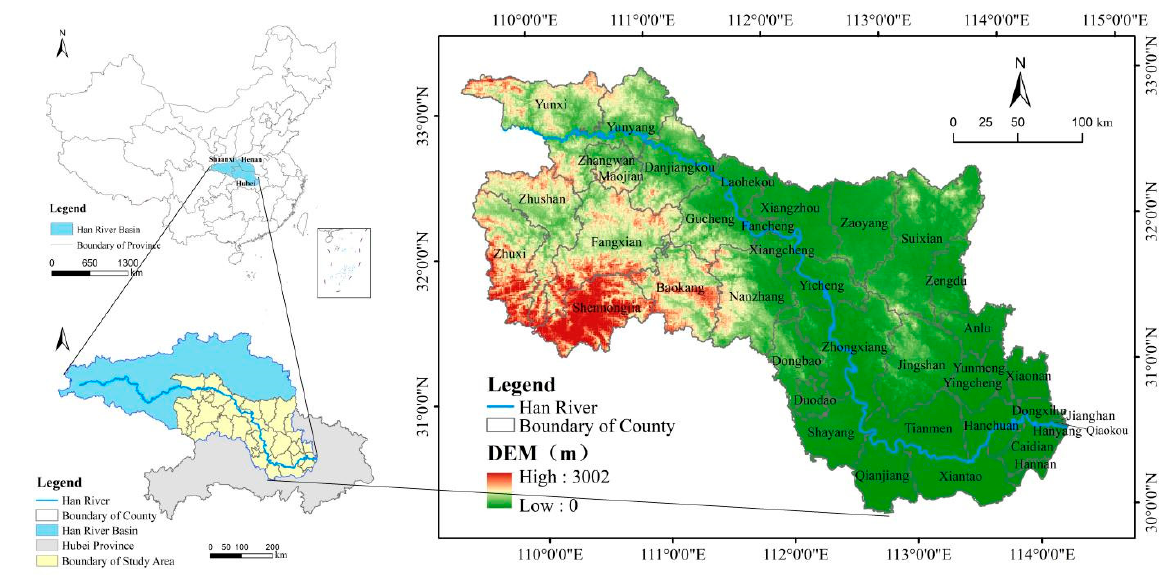
Figure 1. Location of the study area.